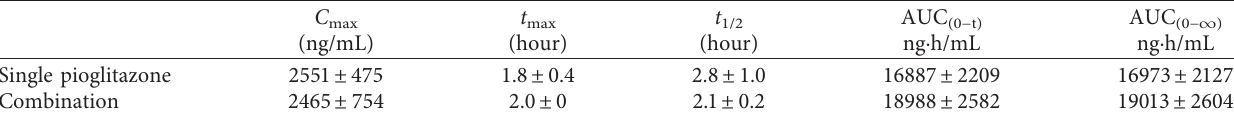
Table 7: Pharmacokinetic parameters of pioglitazone in rats after single or combination administration ( n � 5).